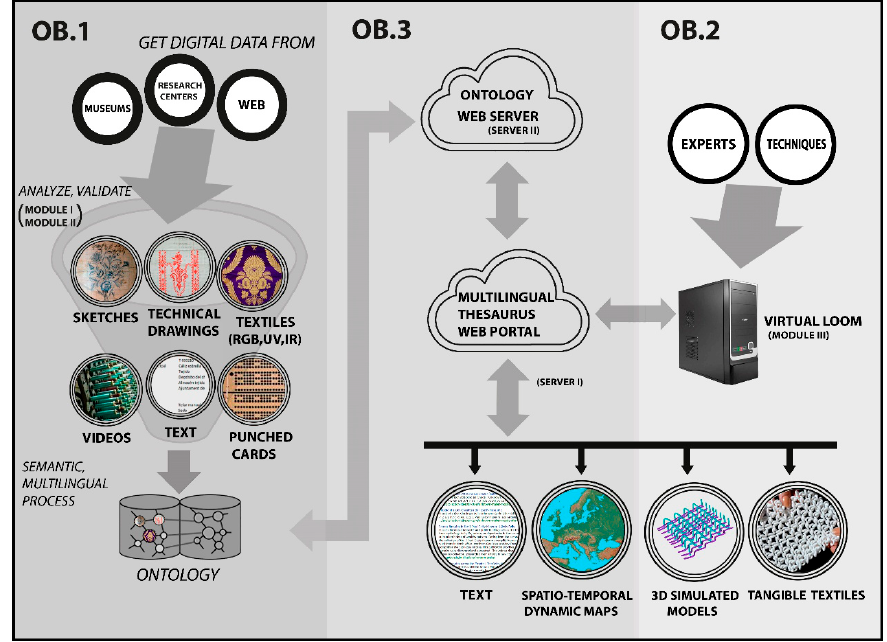
Figure 2. Overview of SILKNOW. The different background grey scales are related to the different objectives of the project (named OB.#).